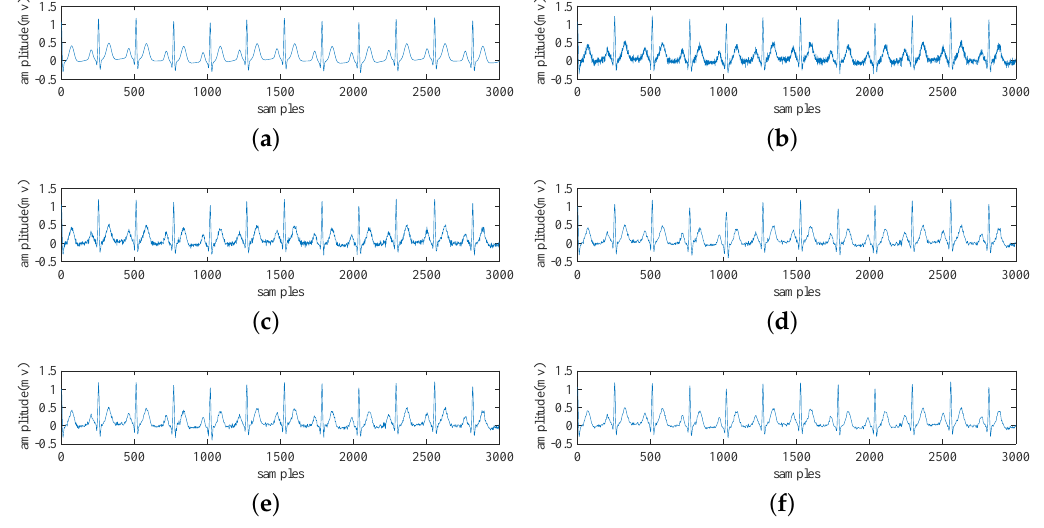
Figure 8. The de-noising results after adding 15 dB WGN to the synthetic ECG: ( a ) The original signal. ( b ) The signal after adding WGN. ( c – f ) De-noised signals using wavelet soft threshold, EMD, EMD soft threshold, proposed